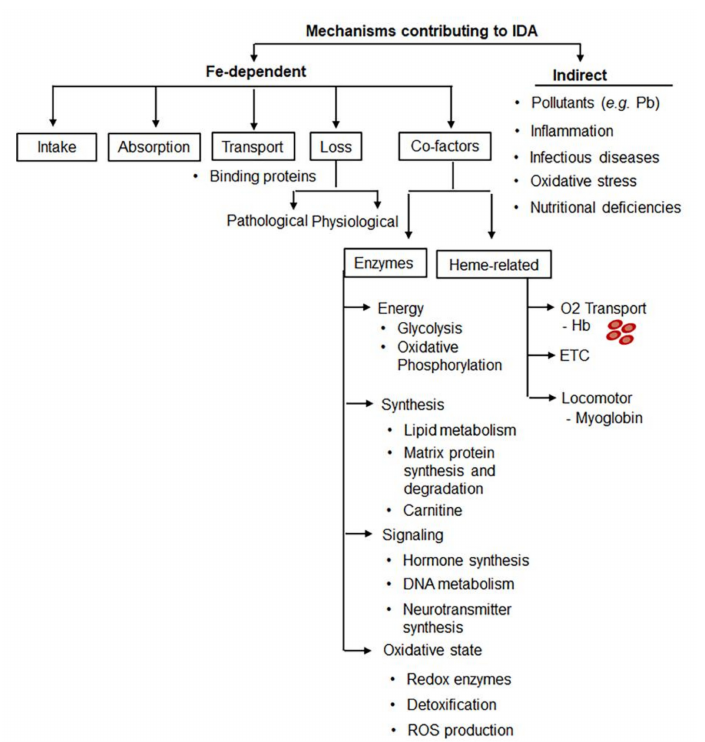
Figure 3. Crosstalk between mechanisms participating in IDA. Pathogenesis of IDA involves iron (Fe)-dependent mechanisms and other factors regulating iron metabolism and erythropoiesis (e.g., essential nutrients, minerals and their metabolites). Iron deficiency, a contributing factor of IDA, can be caused by defective intake, absorption, and transport of iron and/or be a result of iron loss. Digestive, inflammatory, and blood-loss associated pathologies (Table 2) as well as sickle cell anemia and other genetic diseases involve these pathways. Iron deficiency compromises the function of iron-dependent co-factors leading to defective energy production, nervous system, and hormonal regulation dysregulating Hb synthesis and erythropoiesis leading to IDA. Inflammation, infectious diseases, and oxidative stress increase demand for iron and energy production as well as impair absorption of iron and other nutrients, thereby promoting IDA. ETC, electron transfer